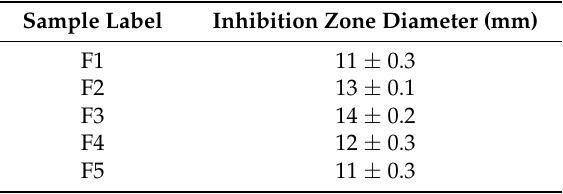
Table 3. Antibacterial activity of the